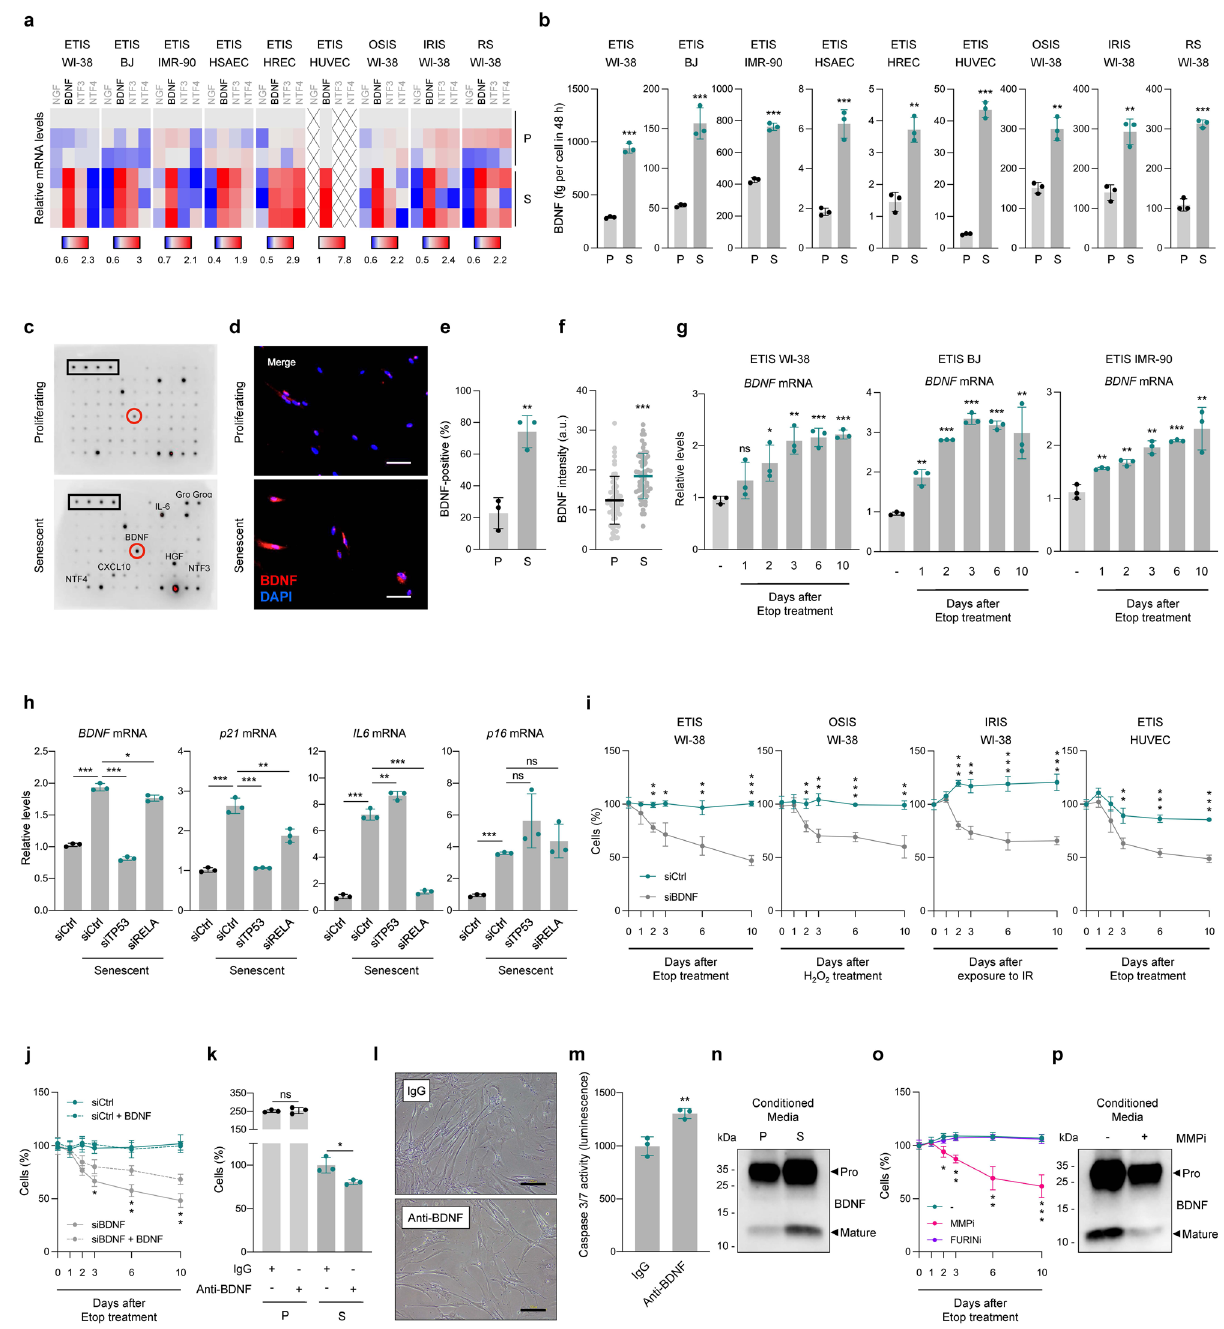
Fig. 4 | BDNF is a SASP factor that ensures viability of senescent cells. a Heat map of the levels of mRNAs encoding neurotrophins as quanti fi ed by RT-qPCR analysis in the senescence models described in Fig. 2c. b ELISA measurement of BDNF levels in conditioned media collected for 48h in the groups shown in a . c Cytokine array analysis of SASP factors and neurotrophins in proliferating and senescent (ETIS) WI-38 fi broblasts. Immuno fl uorescence micrographs of BDNF signal (red) and DAPI-stained nuclei (blue) ( d ), % cells with positive BDNF staining ( e ), and BDNF fl uorescence intensity measurements ( f ) in senescent (ETIS) WI-38 cells. g RT-qPCR analysis of BDNF mRNA levels in senescent (ETIS) WI-38, BJ, and IMR-90 fi broblasts. h RT-qPCR analysis of the levels of BDNF , p21 , IL6 , and p16 mRNAsinsenescent(ETIS)WI-38 fi broblaststransfectedwiththeindicatedsiRNAs, relativetoproliferatingcellstransfectedwithsiCtrl. i WI-38 fi broblastsandHUVECs transfectedwithsiCtrlorsiBDNFwereexposedtosenescence-inducingtreatments (ETIS, OSIS, IRIS); % cells remaining at each time point. j WI-38 fi broblasts were